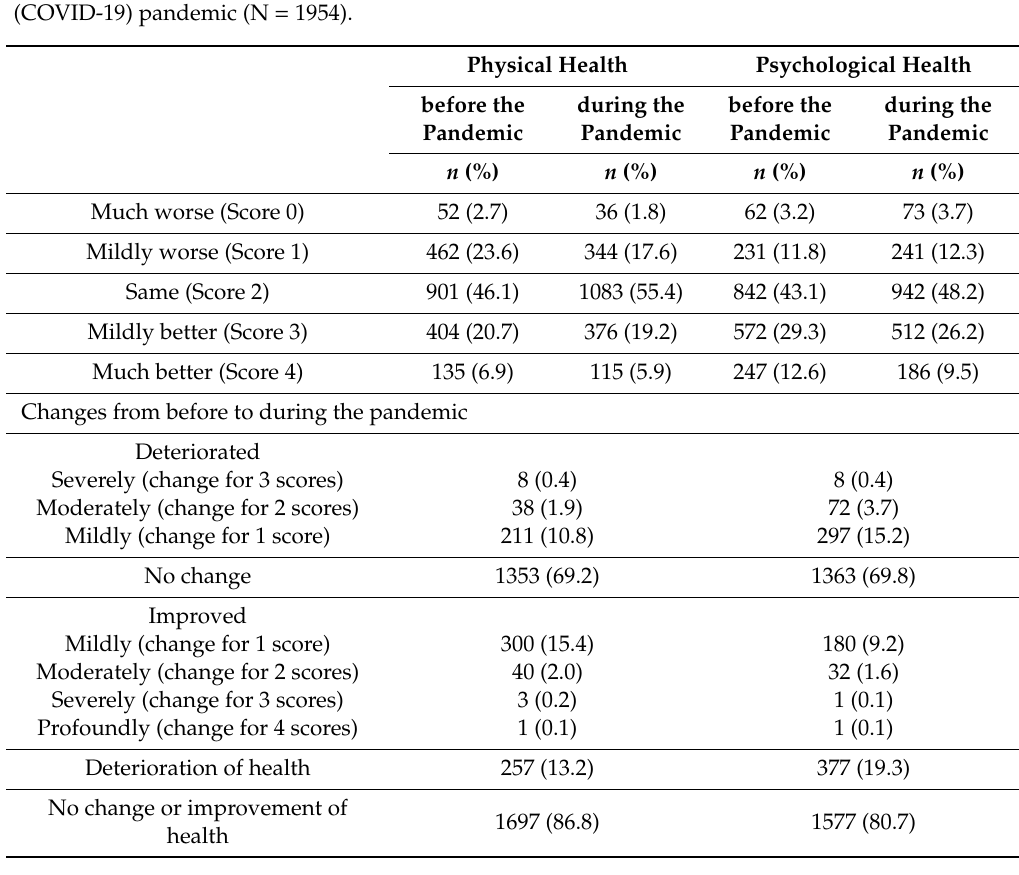
Physical Health Psychological Health before the during the before the during the Pandemic Pandemic Pandemic Pandemic n (%) n (%) n (%) n (%)